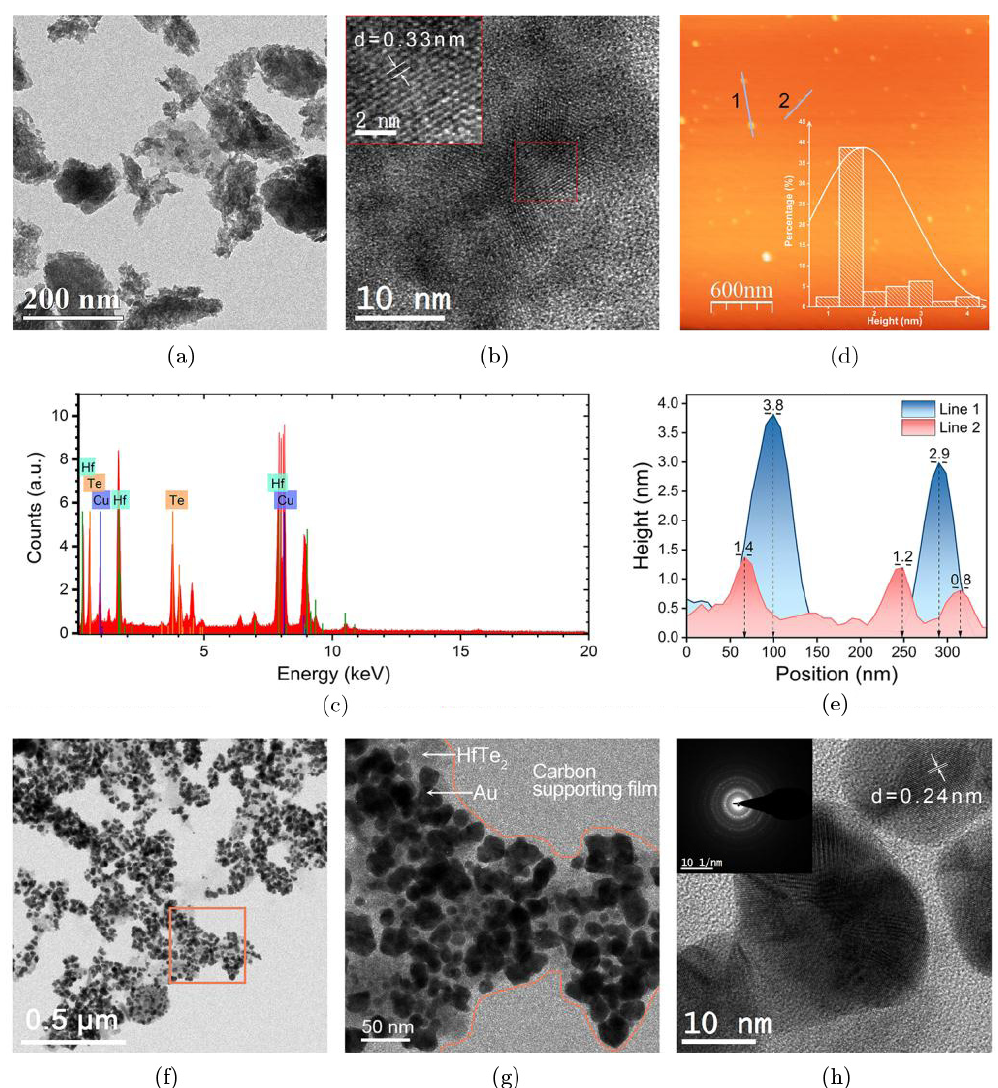
Fig. 2. (a) TEM image and (b) HRTEM image of HfTe 2 nanosheets. (c) EDX pattern of HfTe 2 nanosheets. (d) AFM image with the corresponding thickness distribution (inset) and (e) height pro¯les of HfTe 2 nanosheets. Low-magni¯cation (f) and higher- magni¯cation TEM images of HfTe 2 -Au nanocomposites (g). (h) HRTEM image with the corresponding SAED pattern (inset) of HfTe 2 -Au